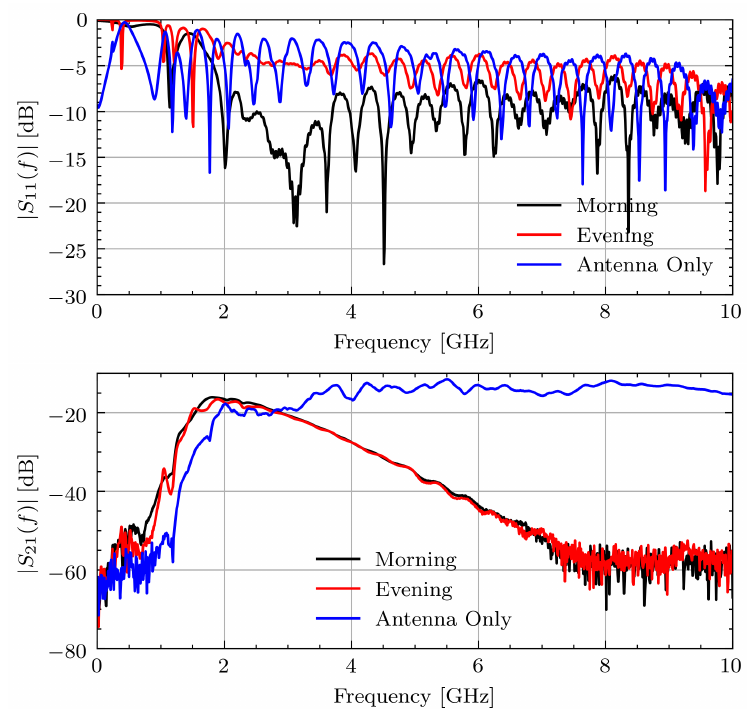
Figure 4. Measured S 11 and S 21 signals for Volunteer A on fasting day